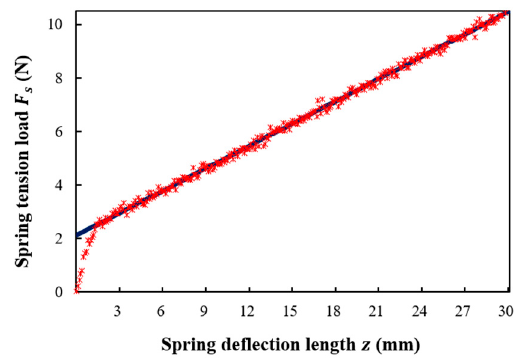
Figure 3. Measured spring tension load F s (N) versus spring deflection length z (mm).